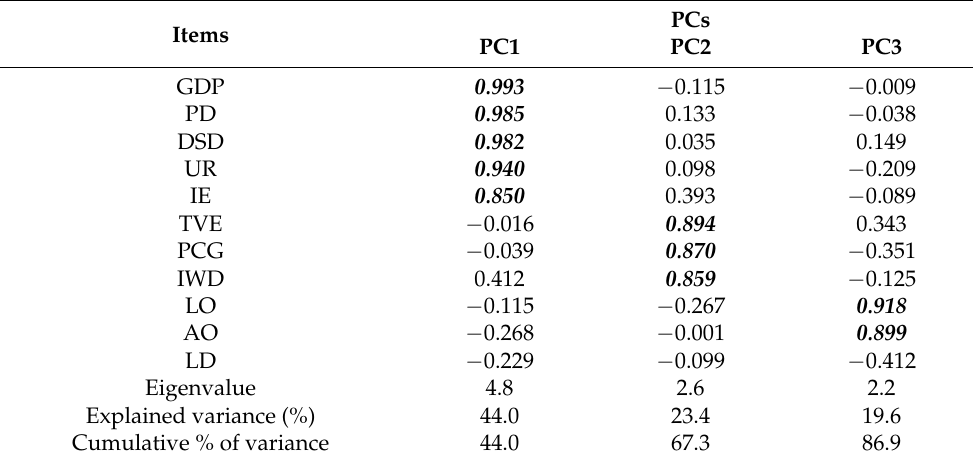
Table 1. Principal component (PC) loadings for groundwater contamination and socioeconomic parameters in nine major cities in the Pearl River